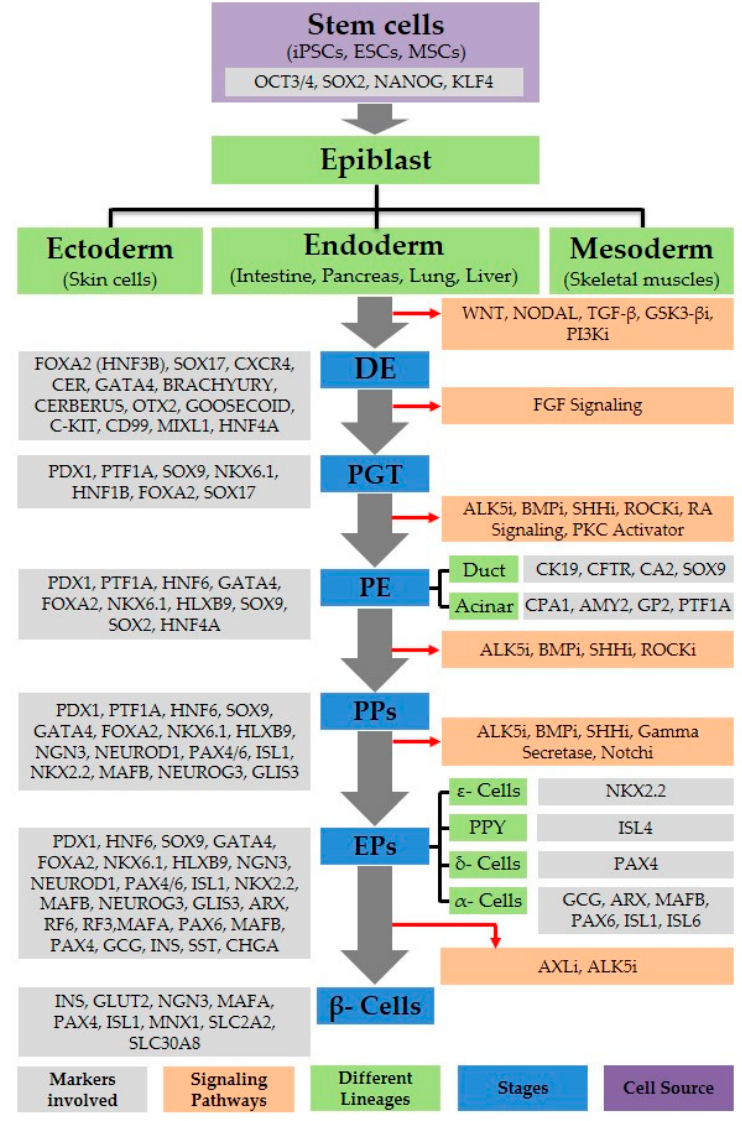
Figure 1. Pancreatic beta-cell development. A flow diagram depicting various lineages of stem cell differentiation toward pancreatic cell progeny. Signaling pathways, as well as markers for various cell types, are shown. i: Inhibitor; DE: Definitive endoderm; (PGT) posterior gut tube, PE: pancreatic